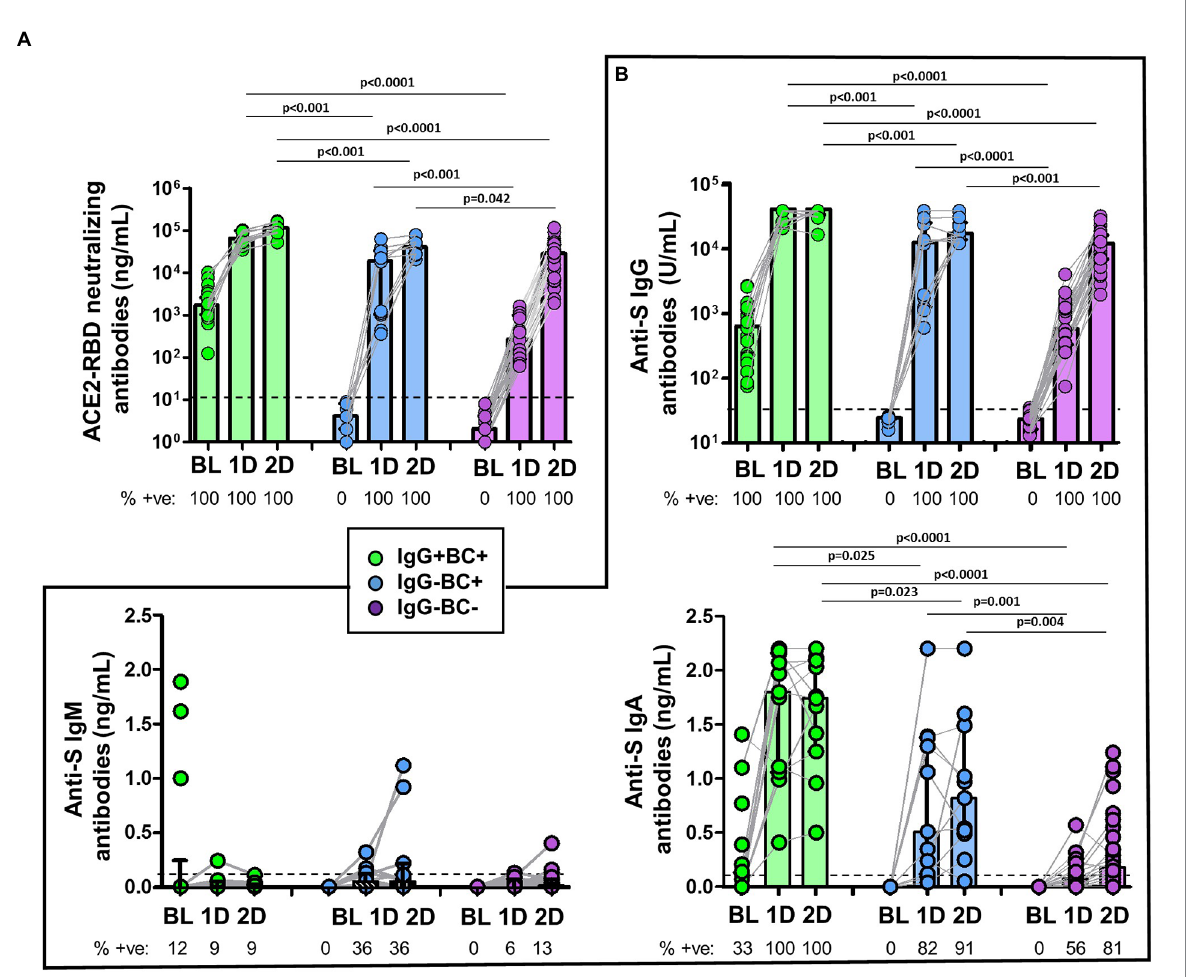
FIGURE 5 (A) Comparison of the levels of ACE2-RBD neutralizing antibodies in IgG + MBC + (green), IgG − MBC + (blue), and IgG − MBC − (purple) groups at baseline and after the first and second doses of the vaccine. The percentage of positive individuals are shown under the figure. Dotted line represents the positivity cut-off. (B) Comparison of the levels of anti-S IgG, IgM and IgA antibodies in IgG + MBC + (green), IgG − MBC + (blue), and IgG − MBC − (purple) groups at baseline and after the first and second doses of the vaccine. The percentage of positive individuals are shown under the figure. Dotted line represents the positivity cut-off. Mann–Whitney test. Only statistically significant values ( p < 0.05) are